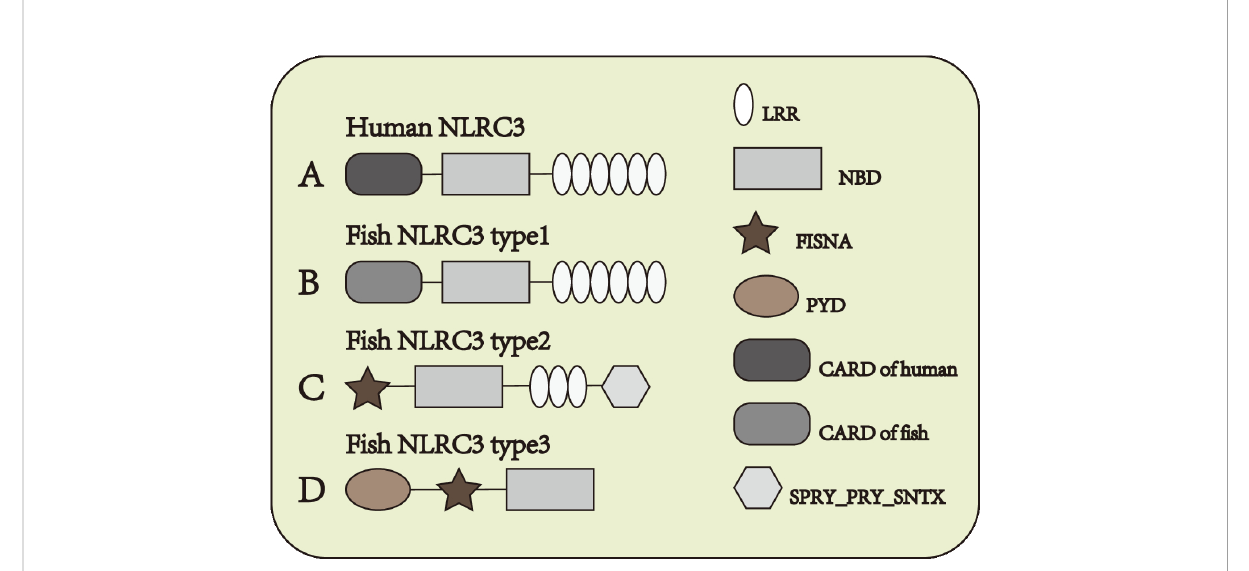
FIGURE 1 Structure of NLRC3 in different species. (A) From N-terminal to C-terminal, human NLRC3 is composed of CARD domain, NBD domain and LRR domain. (B – D) Three types of structures of fi sh NLRC3, from N-terminal to C-terminal, the composition and order of the domain are (B) CARD domain, NBD domain and LRR domain (C) FISNA domain, NBD domain, LRR domain and SPRY_PRY_SNTX domain (D) PYD domain, FISNA domain and NBD